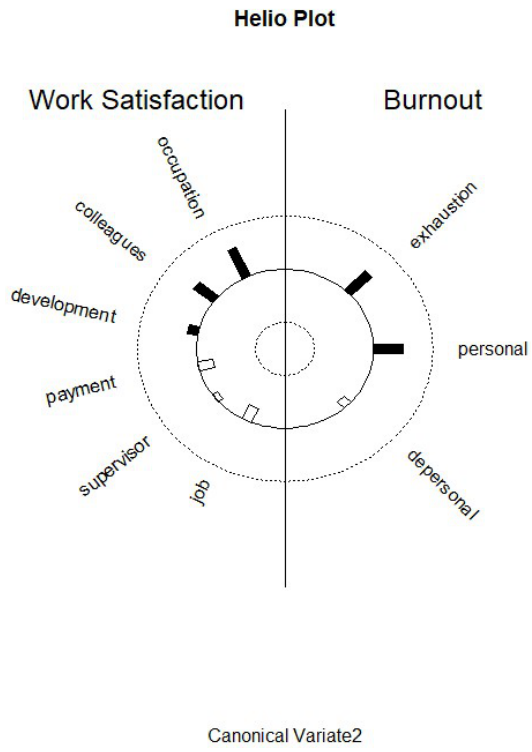
Figure 2. Graphic display of structure correlations (loadings) of the KAFA scales on the second predictor canonical variate and of the structure correlations (loadings) of the MBI scales on the second criterion canonical variate.